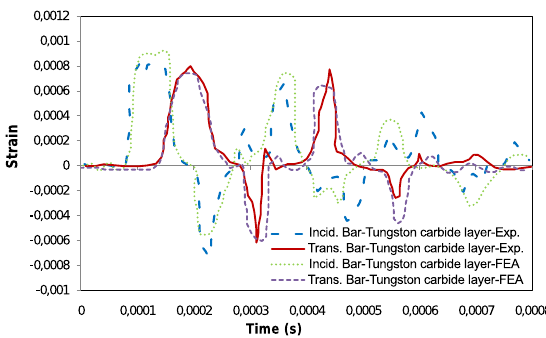
Figure 12. Strain-time curves from incident and transmitted